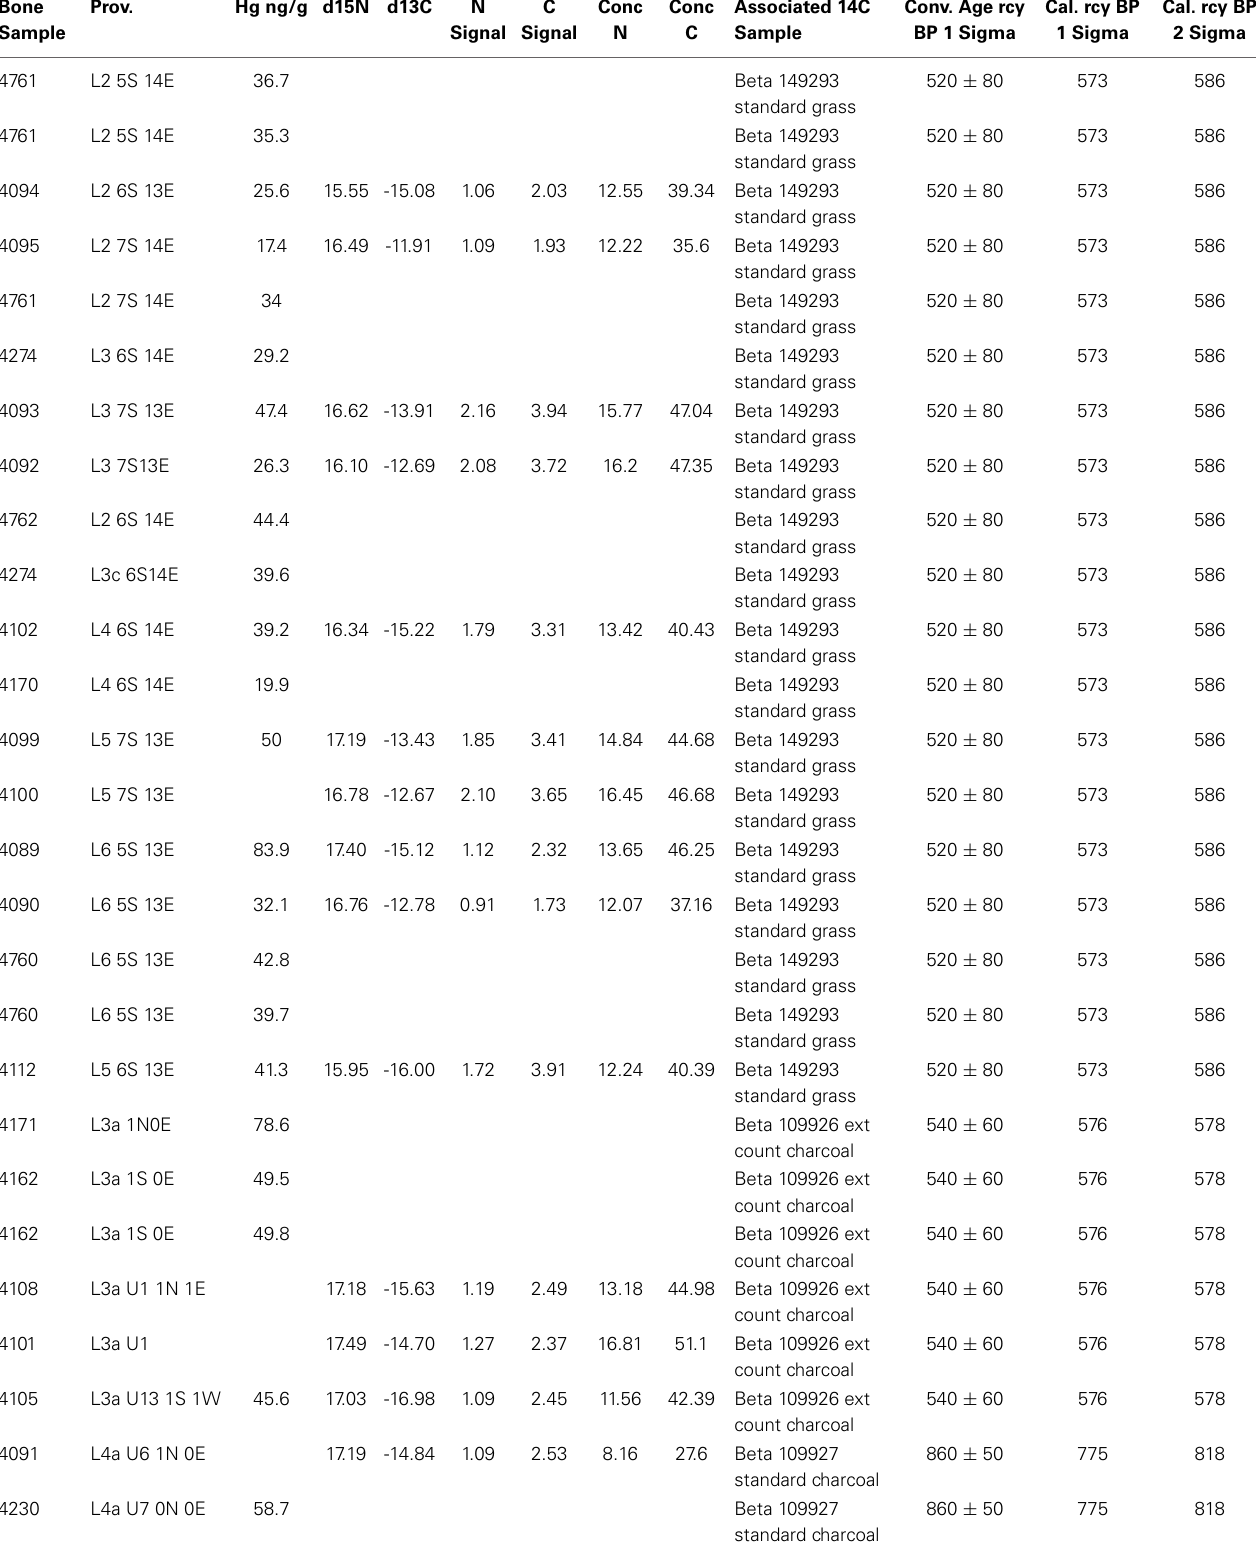
Table 1 | Pacific Cod archeological bone samples: provenience, biogeochemical data and associated radiocarbon samples. Bone Sample